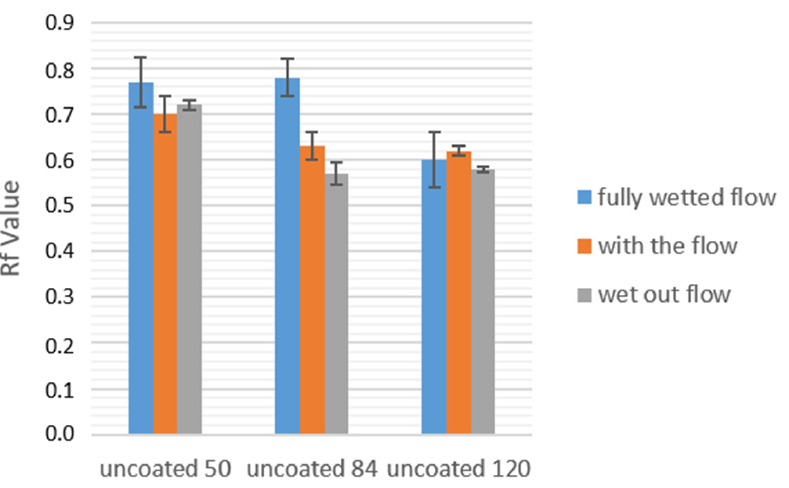
Figure 7. A comparison between cotton linter paper strips of different grammage in terms of the resulting RF values. The applied protein was